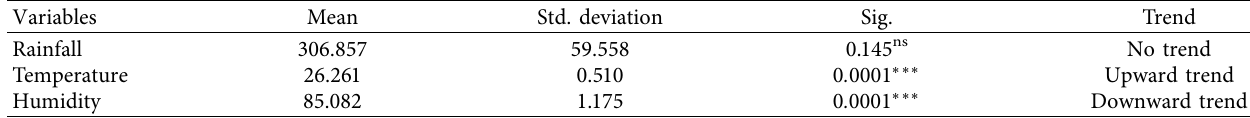
Table 5: Results of Mann–Kendall analysis for selected climatic variables.